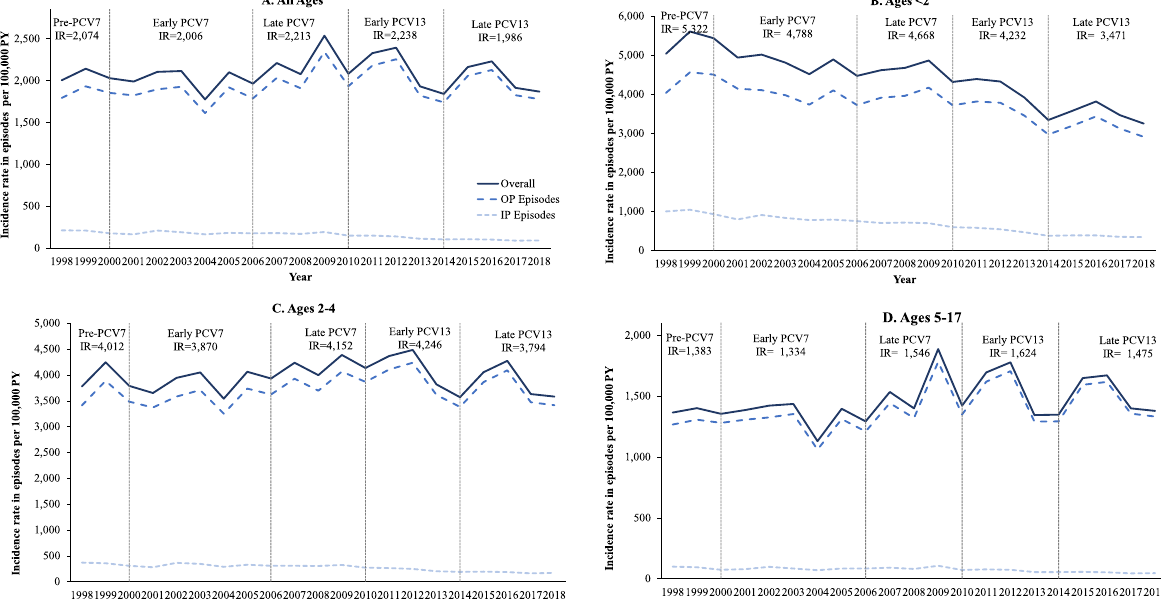
Fig. 1 Trends in annual IRs of ACP episodes per 100,000 PY among commercially insured children aged < 18 years (1998–2018). Notes: Average IRs for total ACP episodes are shown for each PCV period. All patients’ month and day of birth was imputed as July 1st. Age at onset was calculated as the difference between condition start date and imputed birth date. Patients with negative age at onset were included in the age 0–1 year